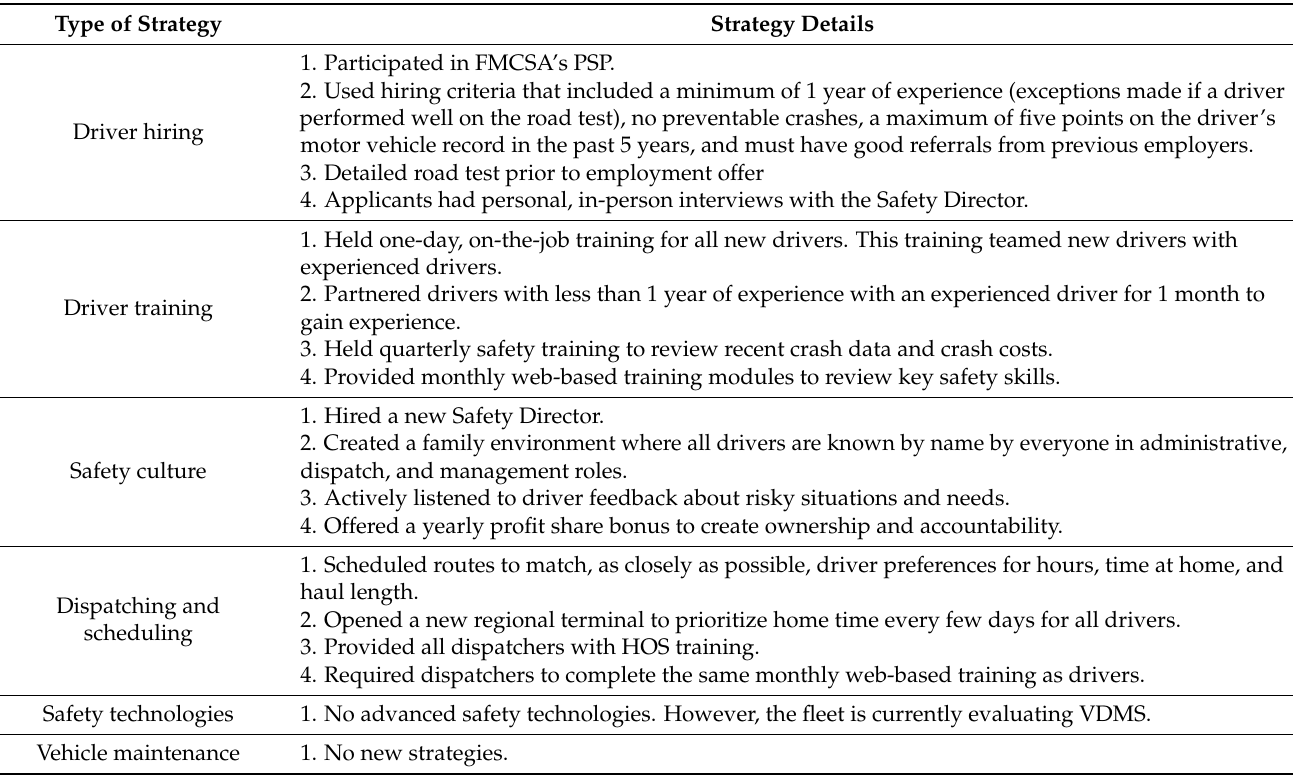
Table 10. Fleet H’s safety improvement